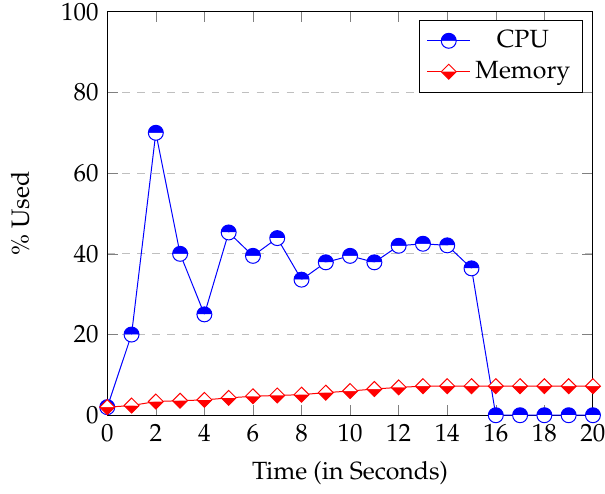
Figure 6. Raspberry CPU and Memory Usage at server’s start